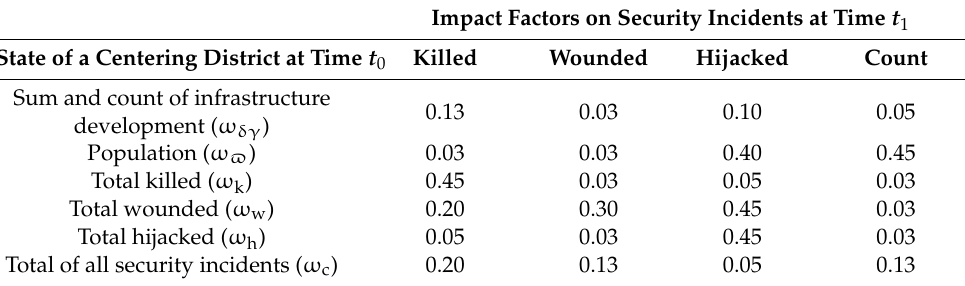
Table 2. Impact of neighboring cell states on security